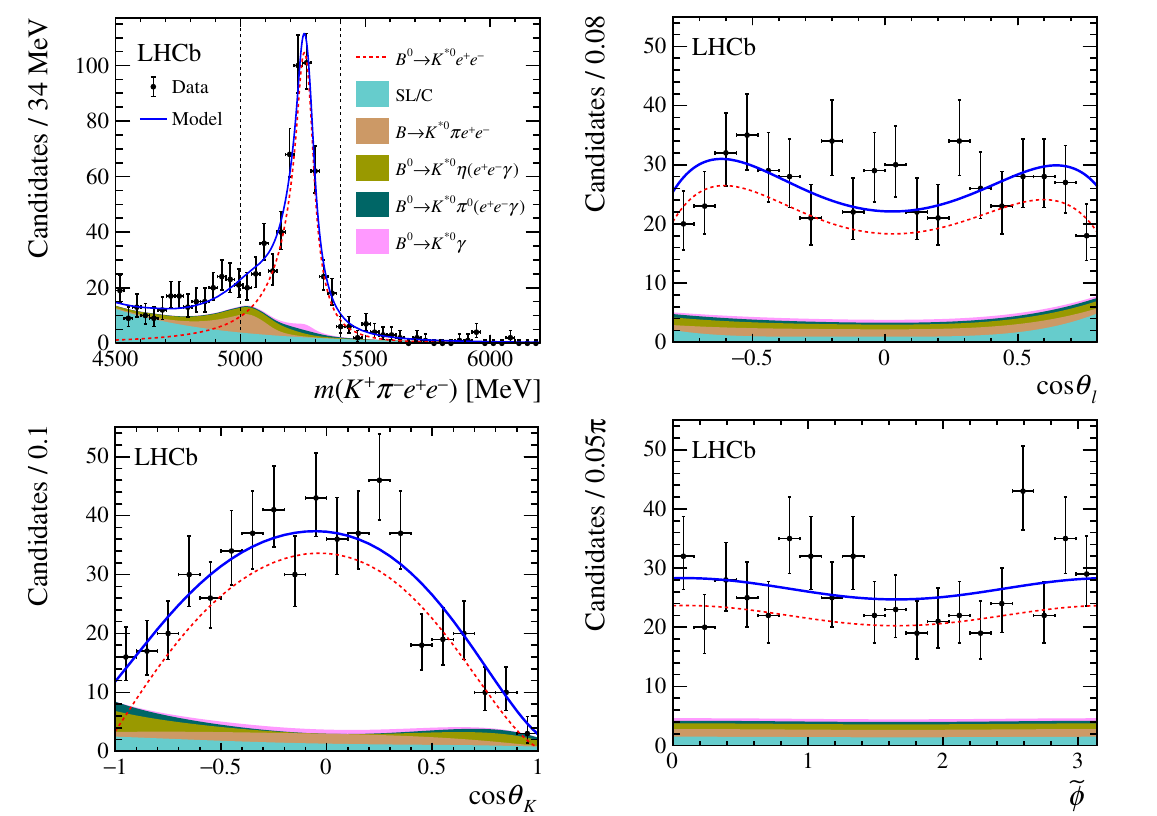
Figure 3 . Distributions of the (top left) K + π − e + e − invariant mass, (top right) cos θ ‘ , (bottom left) cos θ K and (bottom right) ˜ φ variables of B 0 → K ∗ 0 e + e − candidates in the reconstructed q 2 range between 10 − 4 GeV 2 and 0.25 GeV 2 . The black points represent the data, while the solid blue curve shows the total PDF. The signal component is represented by the dashed red line and the shaded areas are the background components, as detailed in the legend. The SL/C component is composed of semileptonic and combinatorial background contributions. The dashed vertical lines indicate the restricted mass range used in the angular